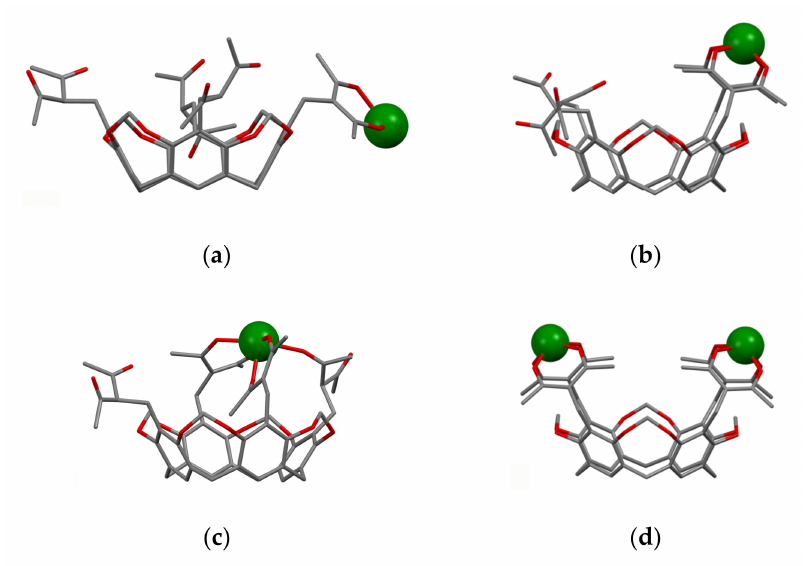
Figure 6. Possible modes of binding of Tb 3+ cations to molecule 26 with participation of one ( a ), two ( b ), three ( c ) and four ( d ) 1,3-diketone groups (lower rim alkyl substituents are omitted)The structures are obtained after PM6 optimization of starting structures built on the basis of single-crystal X-ray data for molecule 26 . Reproduced from Ref. [53] with permission from the Centre National de la Recherche Scientifique (CNRS) and the Royal Society of